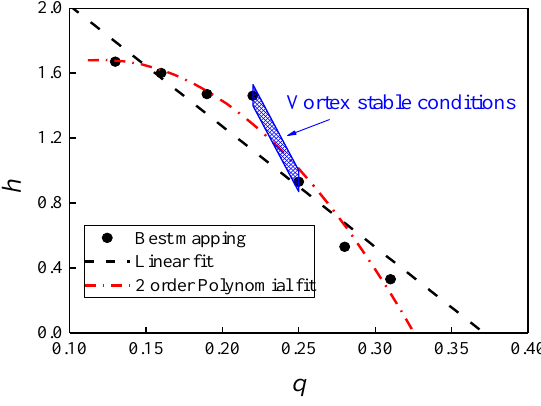
Figure 9. The best mapping between q and h.